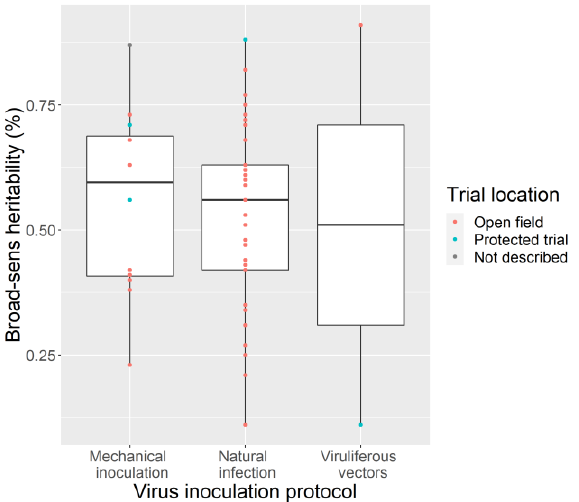
Figure 6. Broad-sense heritability calculated from 47 experiments conducted in 12 plant – virus GWAS (Table S1) using the symptom severity as phenotyping trait regarding the inoculation protocol and the trial type. ‘Mechanical inoculation’ pools inoculations by hand rubbing and mist blower. ‘Protected trial’ pools plant virus GWAS trials which took place in greenhouses, glasshouses, and net protected fields. The second phenotyping step involves collection of data documenting the different resistance levels. Hereafter, the terms of ‘ qualitative ’ and ‘ quantitative ’ are associated with the description of these phenotypic data. Qualitative phenotypes refer to resistance data distributed in classes while quantitative phenotypes refer to resistance data exhibiting continuous values.